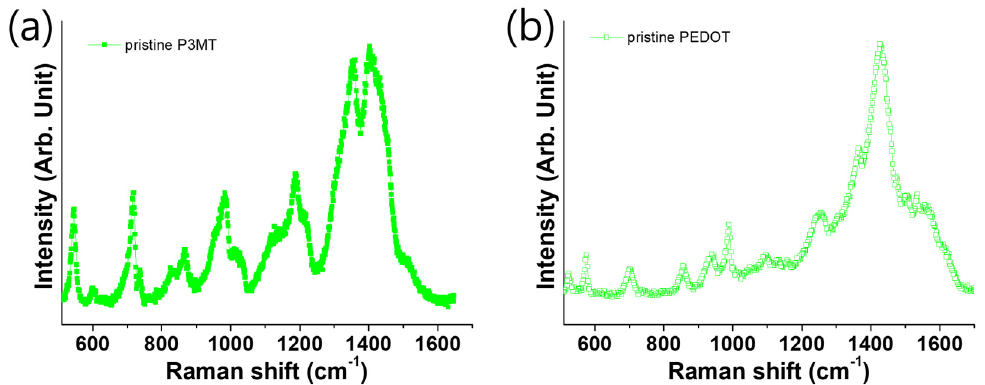
Figure 2. The Raman shift spectra of the ( a ) P3MT and ( b ) PEDOT nanowires excited by a HE-NE laser at 632.8 nm.